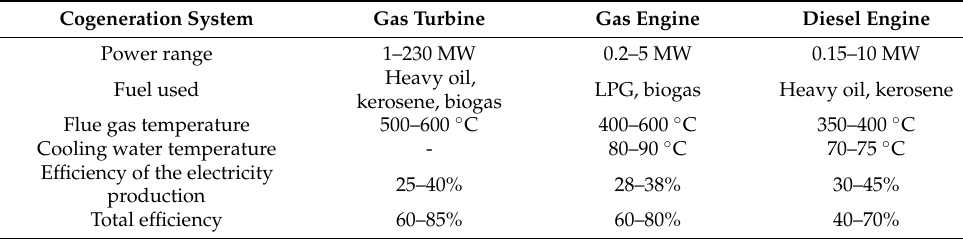
Table 3. Comparison of three cogeneration